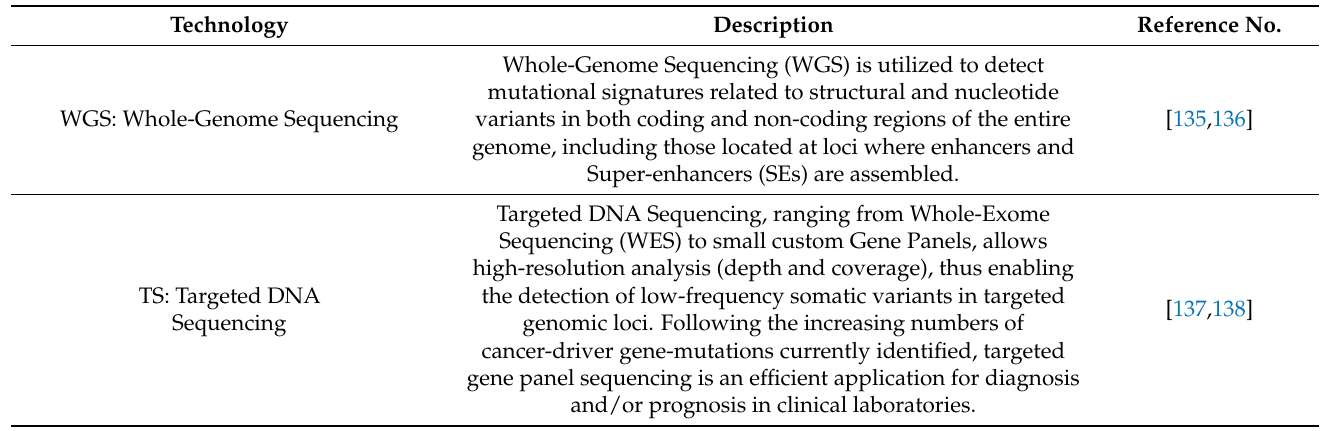
Table 2. Cutting-edge technologies utilized for the analysis of the cancer genome.